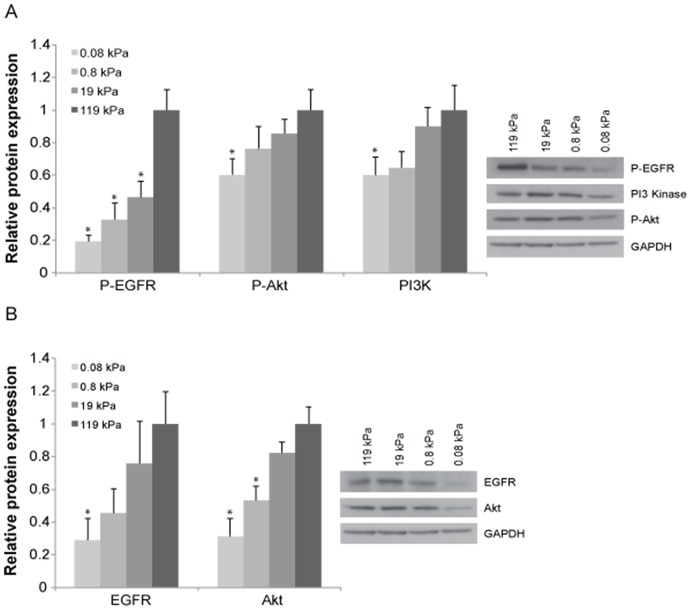
Microenvironmental stiffness regulates expression and phosphorylation of EGFR pathway components.The expression of activated EGFR, activated Akt and PI3K in U373-MG cells rises with increasing substrate stiffness (A). Similarly, the expression levels of EGFR and Akt in U373-MG cells rise with increasing substrate stiffness (B). Results represent quantification of at least three biological replicates on three separate Western blots, where the relative protein expression levels have been first normalized to the expression of GAPDH and then normalized to the expression level on the stiffest substrate of 119 kPa. Representative blots for each protein are on the right. *, P<0.05 with respect to 119 kPa.